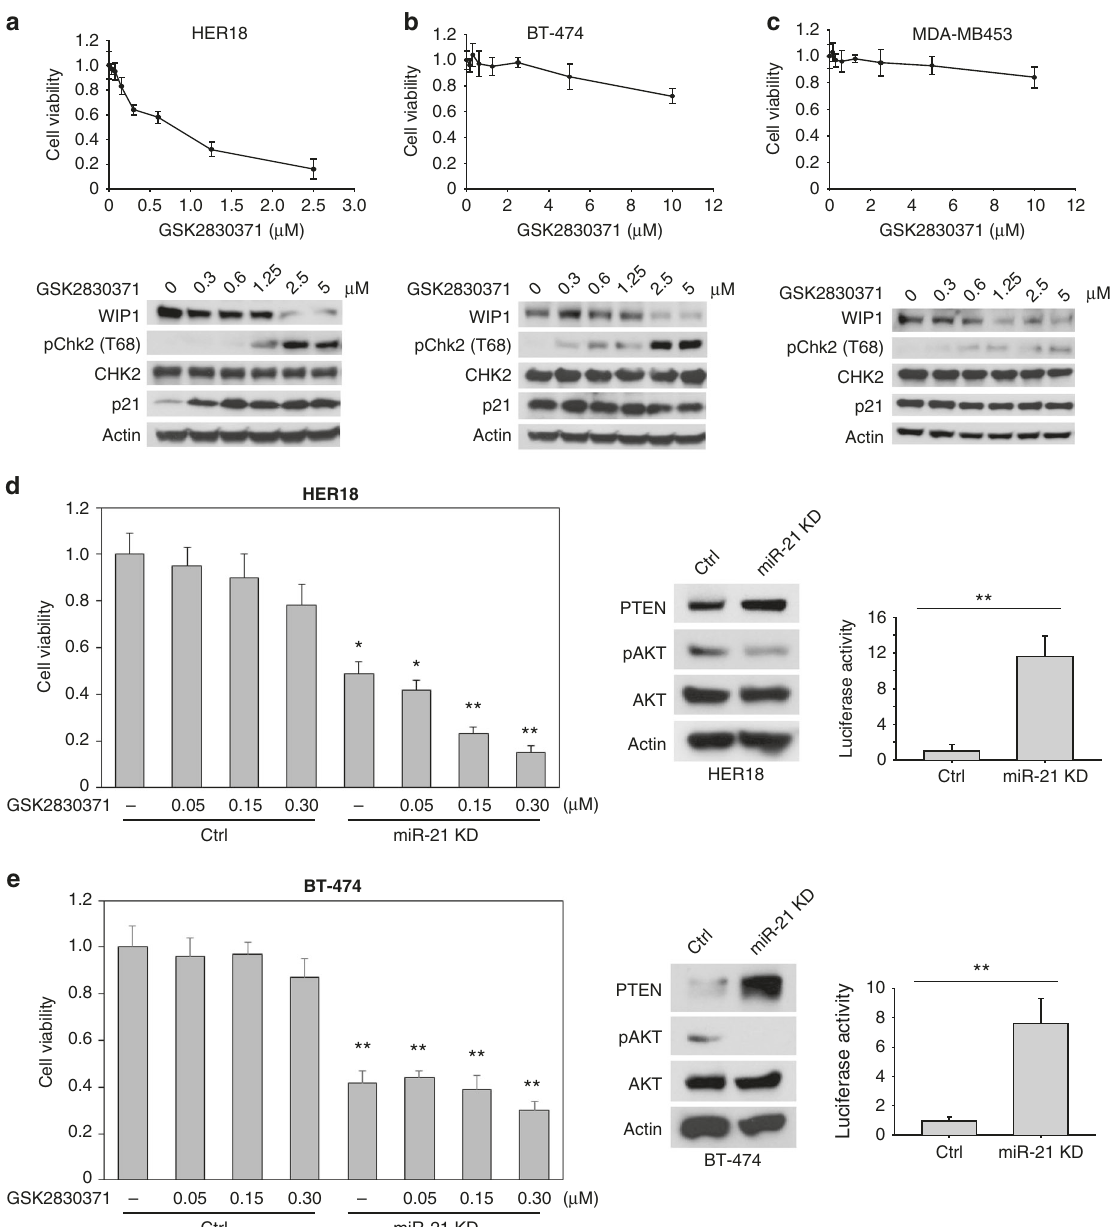
Fig. 5 Inhibition of miR-21 and WIP1 kills HER2 + breast cancer cells harboring 17q23 amplicon. a – c HER18 ( a ), BT-474 ( b ) or MDA-MB-453 ( c ) cells were incubated with or without the WIP1 inhibitor GSK2830371 at the indicated concentrations for 72 h. The cell viability was then measured and these results are presented as % vehicle ± SD. Protein levels are shown at the bottom of each panel by immunoblotting. d , e HER18 ( d ) or BT-474 ( e ) cells with or without Dox-induced miR-21 knockdown were incubated indicated concentrations of GSK2830371 for 72 h. The cell viability was then measured and these results are presented as % vehicle ± SD (left panels). The cell lysates were subjected to Western blot analyses with the indicated antibodies (middle panels). Knockdown ef fi ciency of miR-21 was measured by luciferase reporter assay (right panels). * p < 0.05; ** p < 0.01; unpaired 2-tailed t -test was used ( d , e ). Data are presented as mean ± SD and are representative of 3 independent